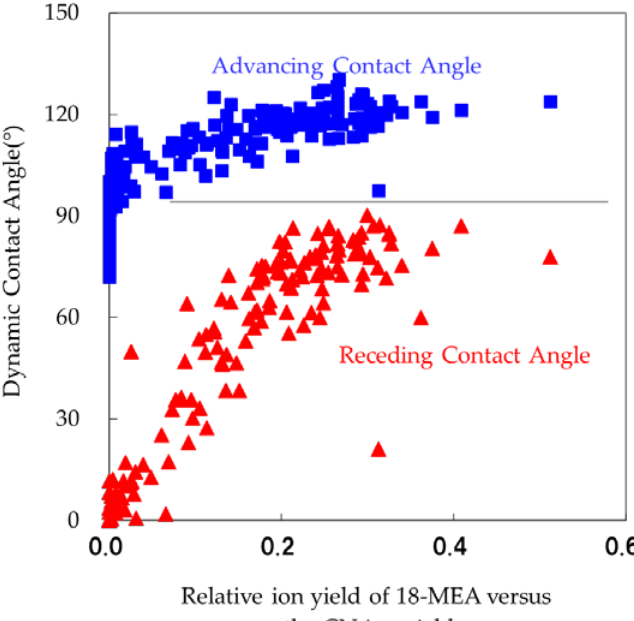
Figure 1. Relationship between dynamic contact angles (advancing and receding) and the semi-quantitative amount of 18-methyleicosanoic acid (18-MEA) on the surface of Japanese female hair measured by TOF-SIMS.